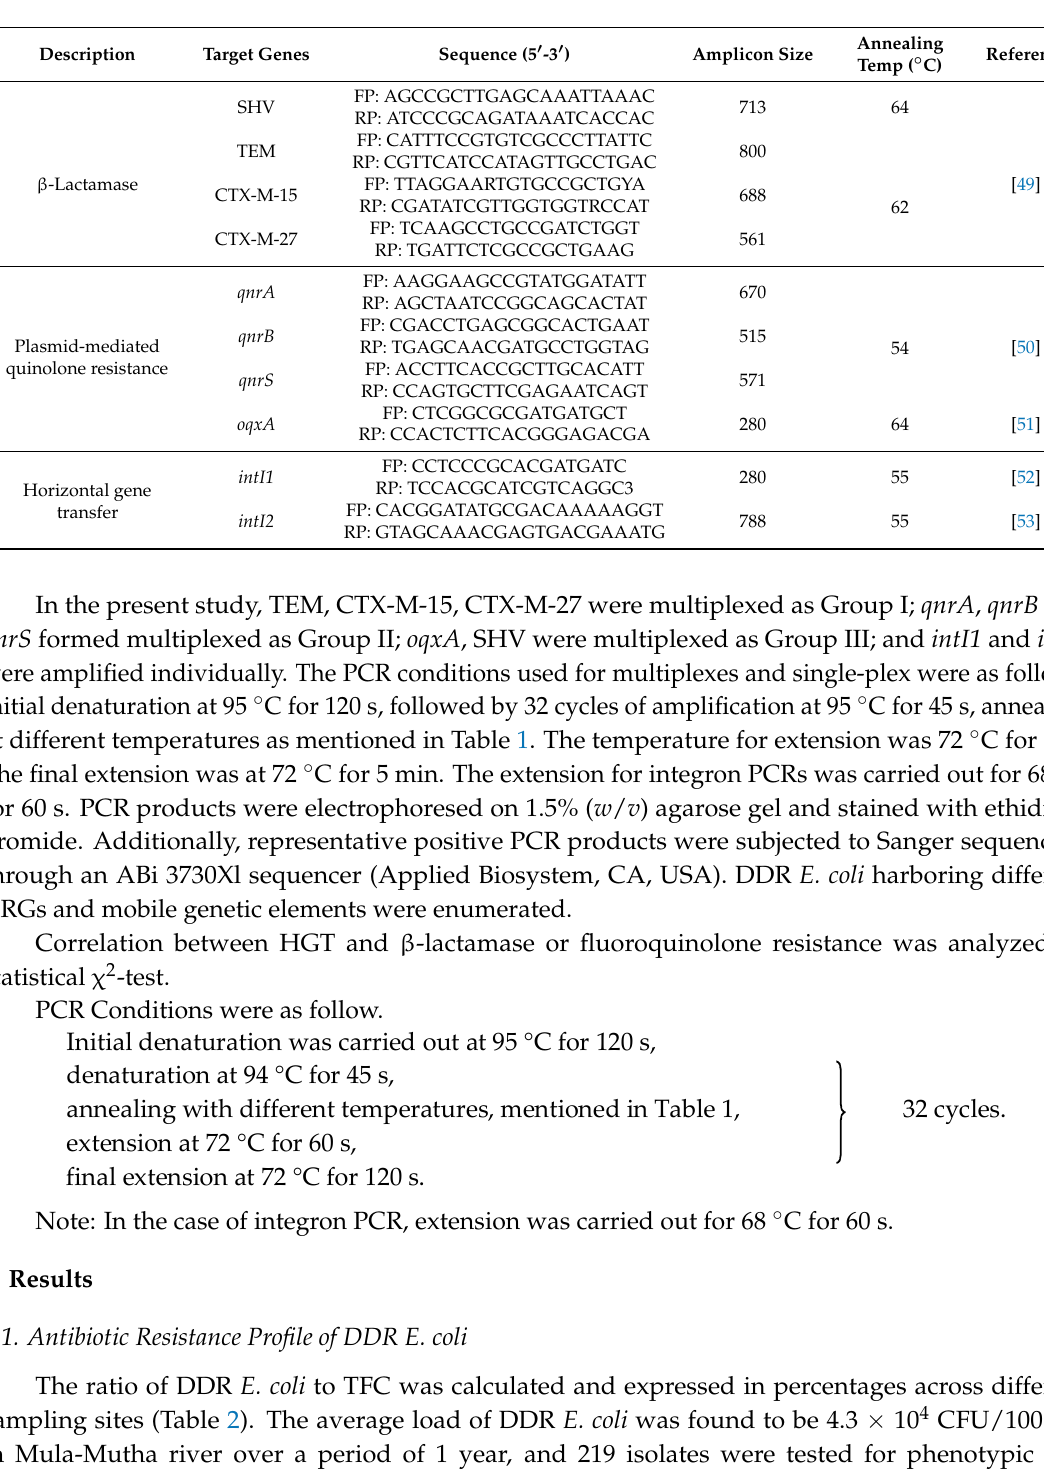
Table 1. Sequences of primers, PCR conditions, annealing temperature for amplifying target genes.